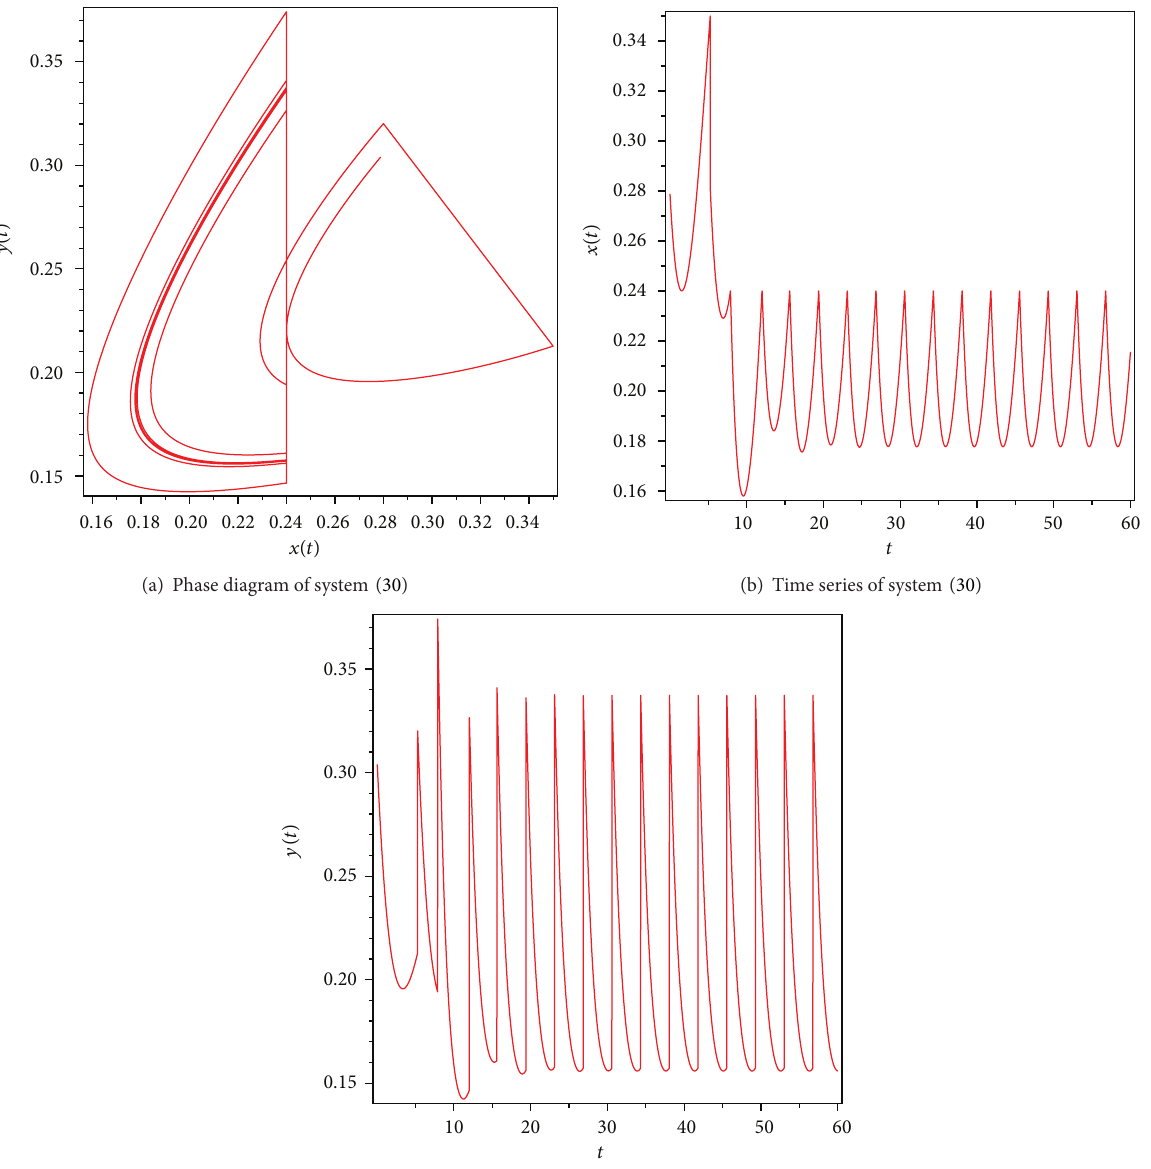
Figure 9: 1-periodic solution in the area Ω 1 = {(𝑥,𝑦) | ℎ 1 < 𝑥 < ℎ 2 } corresponding to Figure 4(c) does not exist.